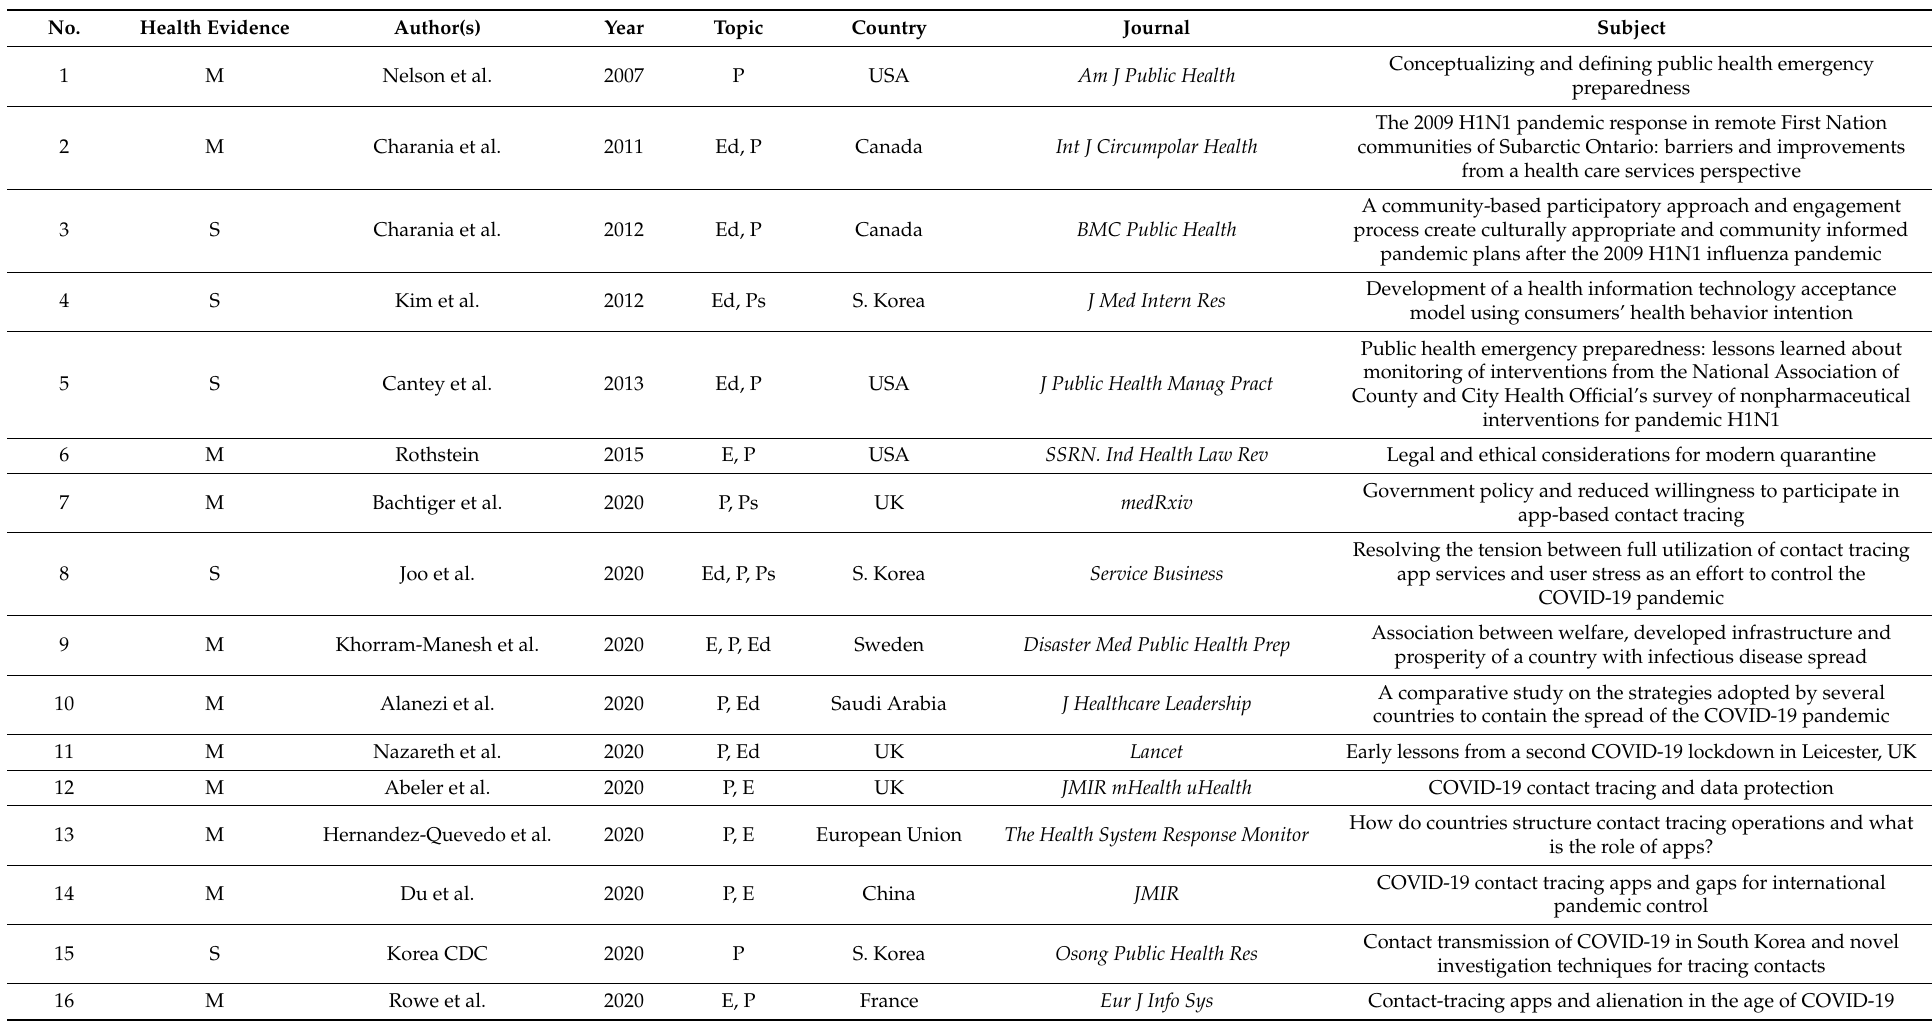
Table 1. Shows the included studies, health evidence, information about authors and their affiliation, year of publication and the main topic of discussion, journal, and subject description. Topics are shown as E = Ethical, Ed = Educational, P = Practical, and Ps = Psychological.